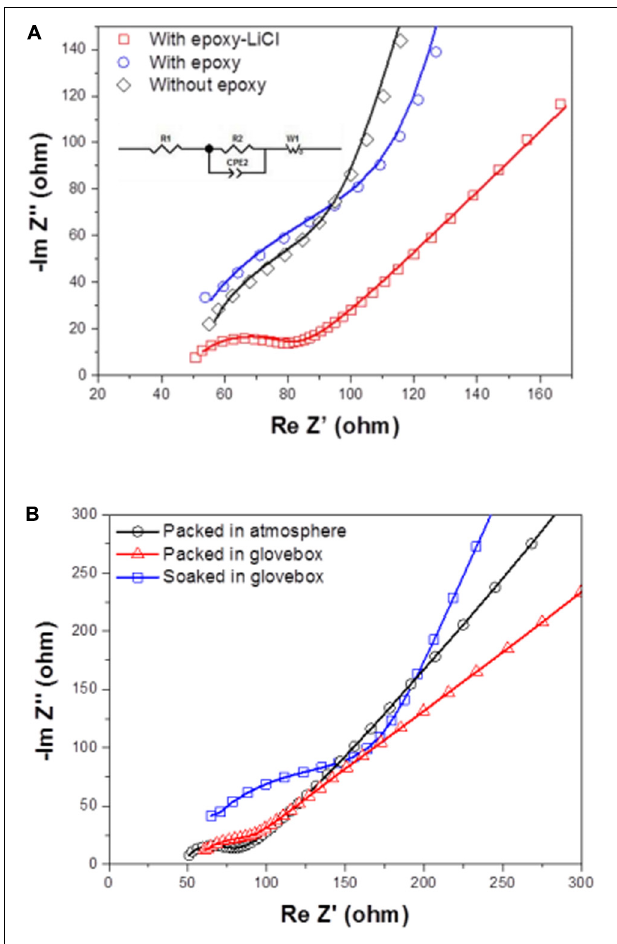
FIGURE 4 | Impedance profiles measured at 25 ◦ C of (A) Au/LAGTP/Au, Au/LAGTP-E/Au, and Au/LAGTP-E-LiCl/Au packed in plastic envelops under an air atmosphere, and of (B) Au/LAGTP-E-LiCl/Au packed under an air atmosphere ( ) and in Ar-filled glove box ( (cid:77) ), where LAGTP was soaked in a tetrahydrofuran (THF) solution of the epoxy precursor with saturated LiCl (cid:35) under air atmosphere, and Au/LAGTP-E-LiCl/Au packed in an Ar-filled glove box ( (cid:3) ), where LAGTP was soaked in a THF solution of the epoxy precursor with saturated LiCl in an Ar-filled glove box.